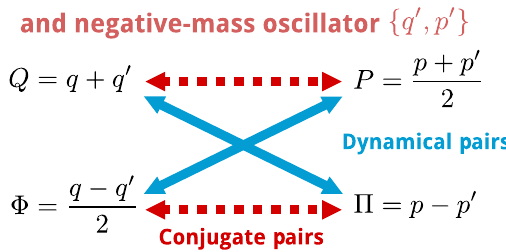
FIG. 3. Behavior of positive-mass (blue) and negative-mass (red) oscillators during a short time interval (cid:4) t . Monitoring the collective position Q leads to the same backaction force f on both oscillators. The positive-mass oscillator is ‘‘pushed’’ by f , whereas the negative-mass oscillator is ‘‘pulled’’ in the opposite direction; the effect of the backaction thus cancels in Q . The evolution of Q under an external force F applied to the positive-mass oscillator is exactly the same as that of a single oscillator. Positive- and negative-mass oscillators can be realized as blue and red sidebands of a carrier